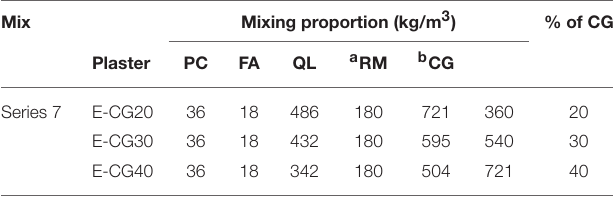
a Red mud. b Coal gangue and waste glass.